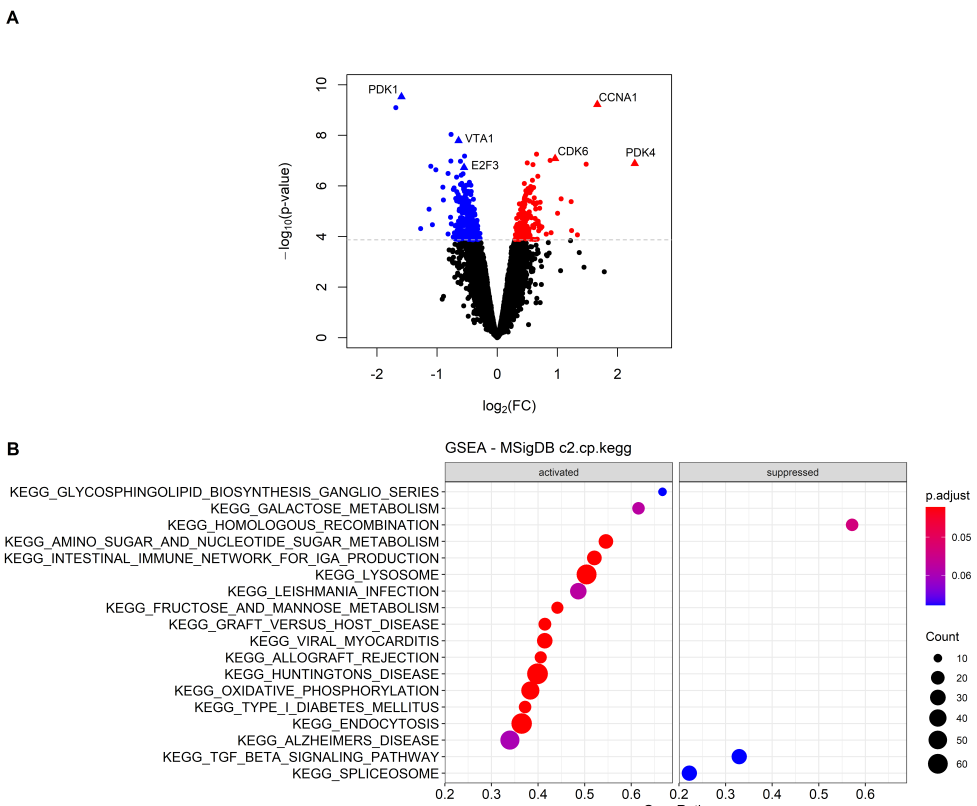
Figure 6. Differentially expressed genes and KEGG pathways significantly enriched in shPDK1 vs. control OVCAR3 tumors. ( A ) Volcano plot showing significantly upregulated (red) and downregulated (blue) genes in the comparison shPDK1 vs. shRNA OVCAR3 tumors. The x-axis represents the log2(FC) and the y-axis the − log10 ( p -value). Dashed grey line corresponds to the cut-off of 0.01 on Benjamini–Hochberg adjusted p -value used to determine DEGs. Interesting genes explicitly cited within the manuscript are indicated with triangles and annotated. ( B ) Dot plot showing the results of Gene Set Enrichment Analysis (GSEA) on the KEGG pathway from “c2.cp.kegg” subcollection of the MSigDB. The 15 most significantly activated and the 3 significantly suppressed pathways, considering a Benjamini–Hochberg (BH) adjusted p -value < 0.10, are displayed. The size of each dot (count) represents the number of genes contributing to the enrichment of that pathway, and the color represents the Benjamini–Hochberg adjusted p -value (red dots are the most significant). Enriched KEGG pathway are ordered by decreasing gene ratio (count/size of the gene